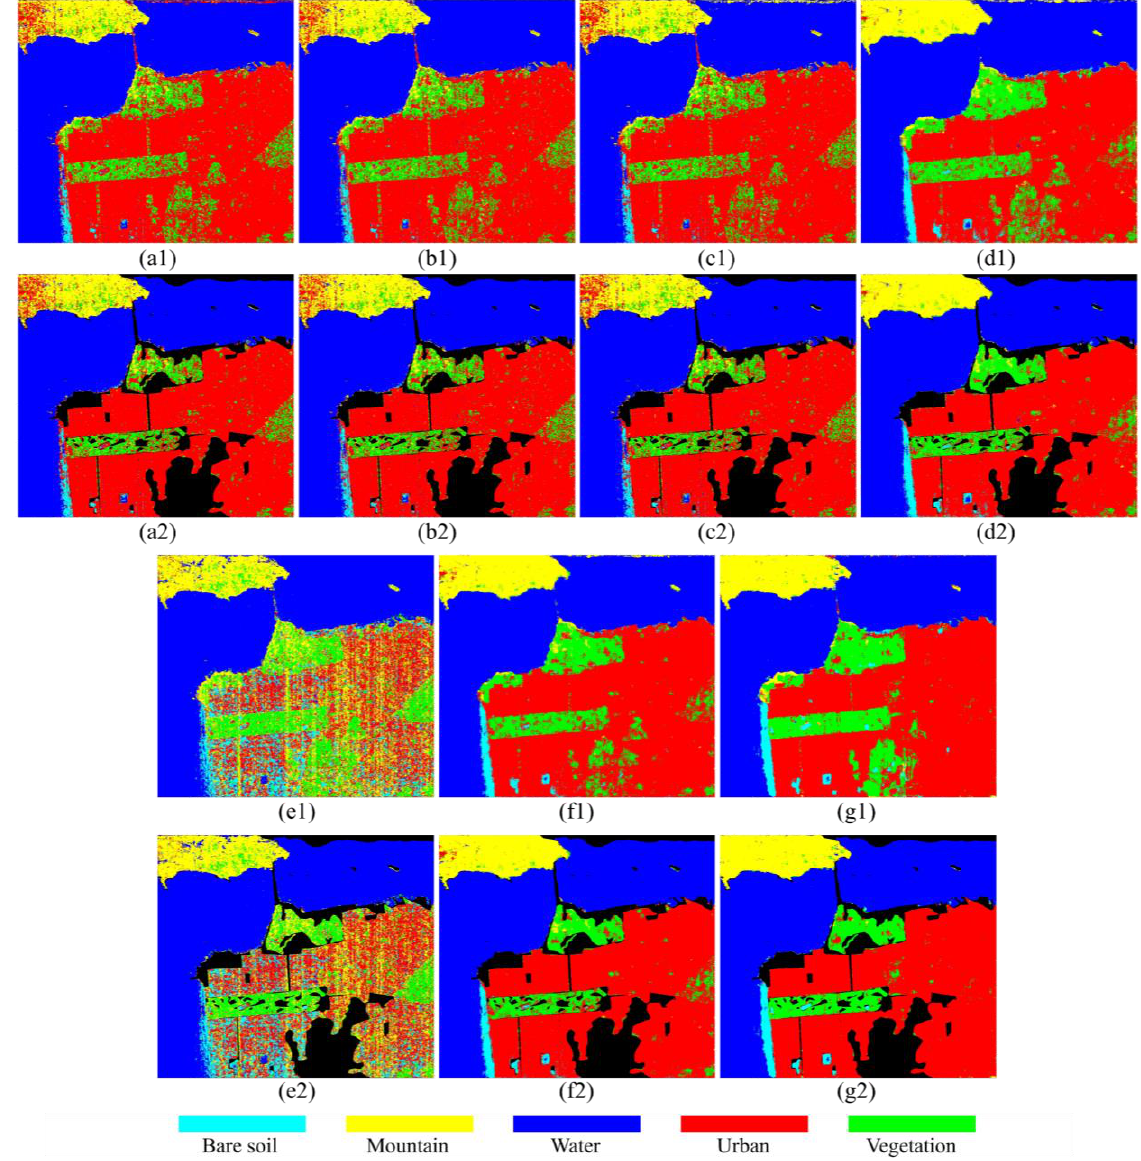
Figure 10. AIRSAR San Francisco classification maps of ( a1 ) SVM, ( b1 ) RF, ( c1 ) 1D-CNN, ( d1 ) 2D-CNN, ( e1 ) miniGCN, ( f1 ) FuNet, and ( g1 ) dual-branch FuNet. ( a2 ) – ( g2 ) Masked results according to the ground-truth of ( a1 ) – ( g1 ).